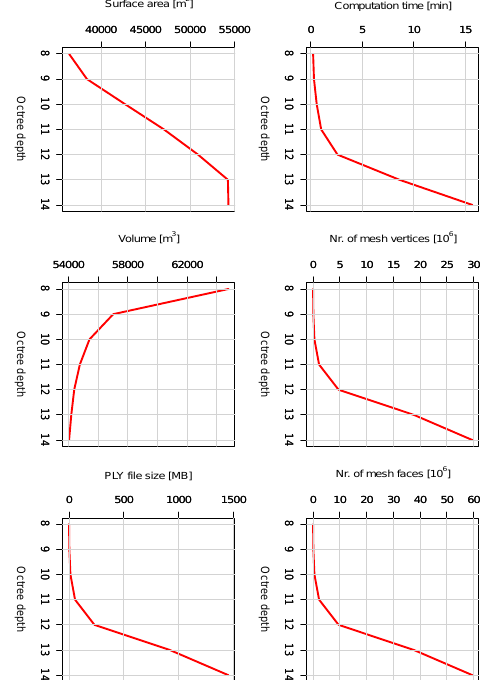
Figure 13. Relation between the octree depth parameter of the Pois- son surface reconstruction in Meshlab and the associated compu- tational time, number of vertices, number of facets, output mesh surface area, mesh volume, and file size. The input point cloud con- tained 12718million of TLS points representing the Domica cave which were processed on a desktop PC with the 64bit Windows operation system, 16GB RAM, and eight i7 CPUs of